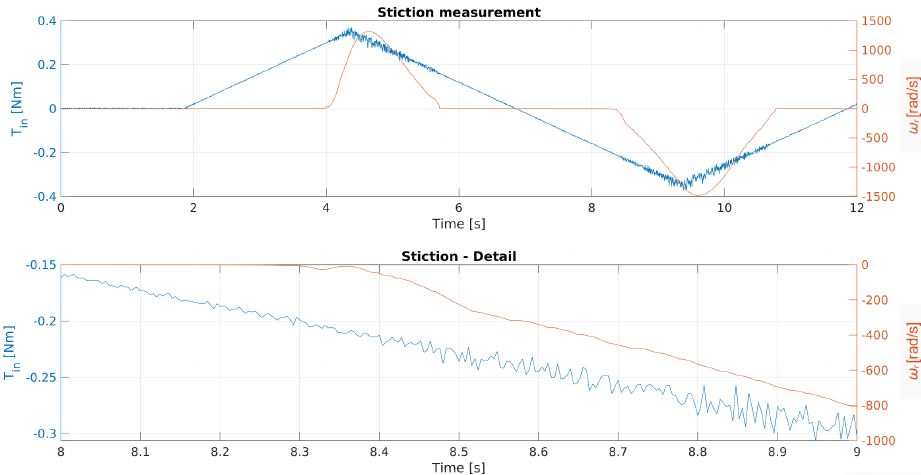
Figure 3. A stiction